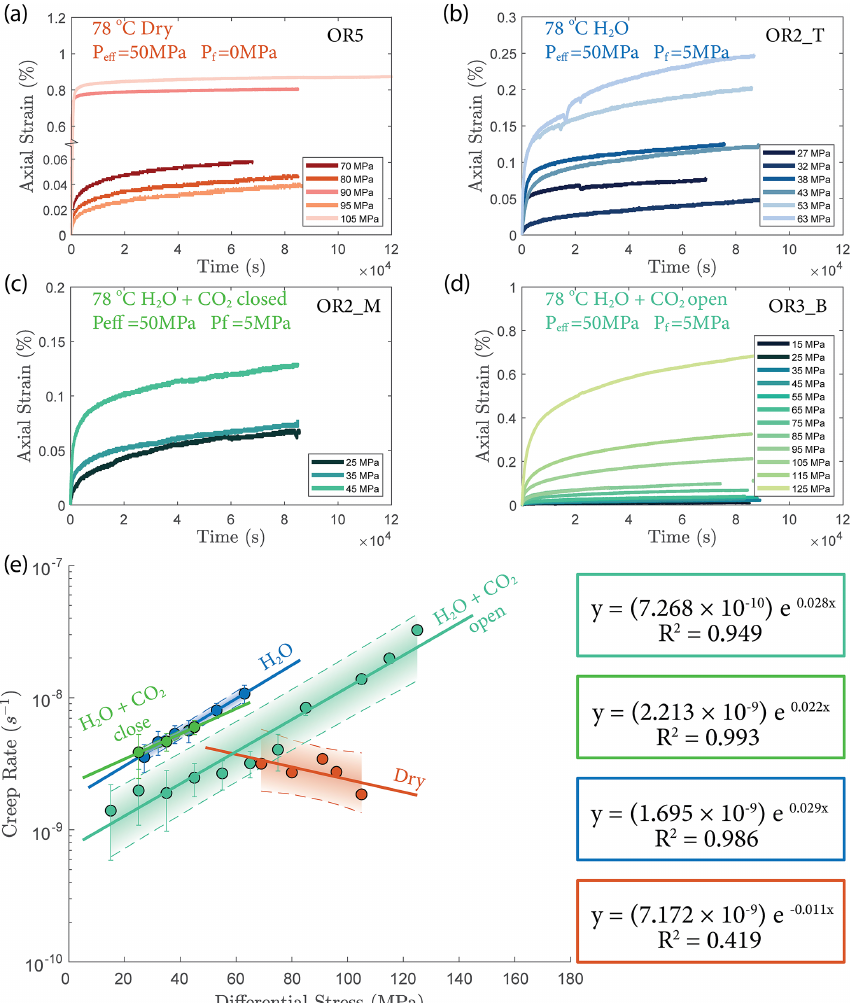
Figure 3. (a–d) Axial strain evolution of each individual stress step for all experiments; (e) stress dependence of creep rate. The error bar marks the 95% confidence interval of each calculated creep rate. The stress–creep rate relationship can be best modeled using an exponential law. The dashed line and shaded area mark the 95% confidence interval of the fitted exponential relationship. The stress dependence of creep rate in the dry experiment is considered neutral as the R 2 becomes low for the fitting with negative slope. Color code of the plot follows the same pattern as panels (a) – (d)